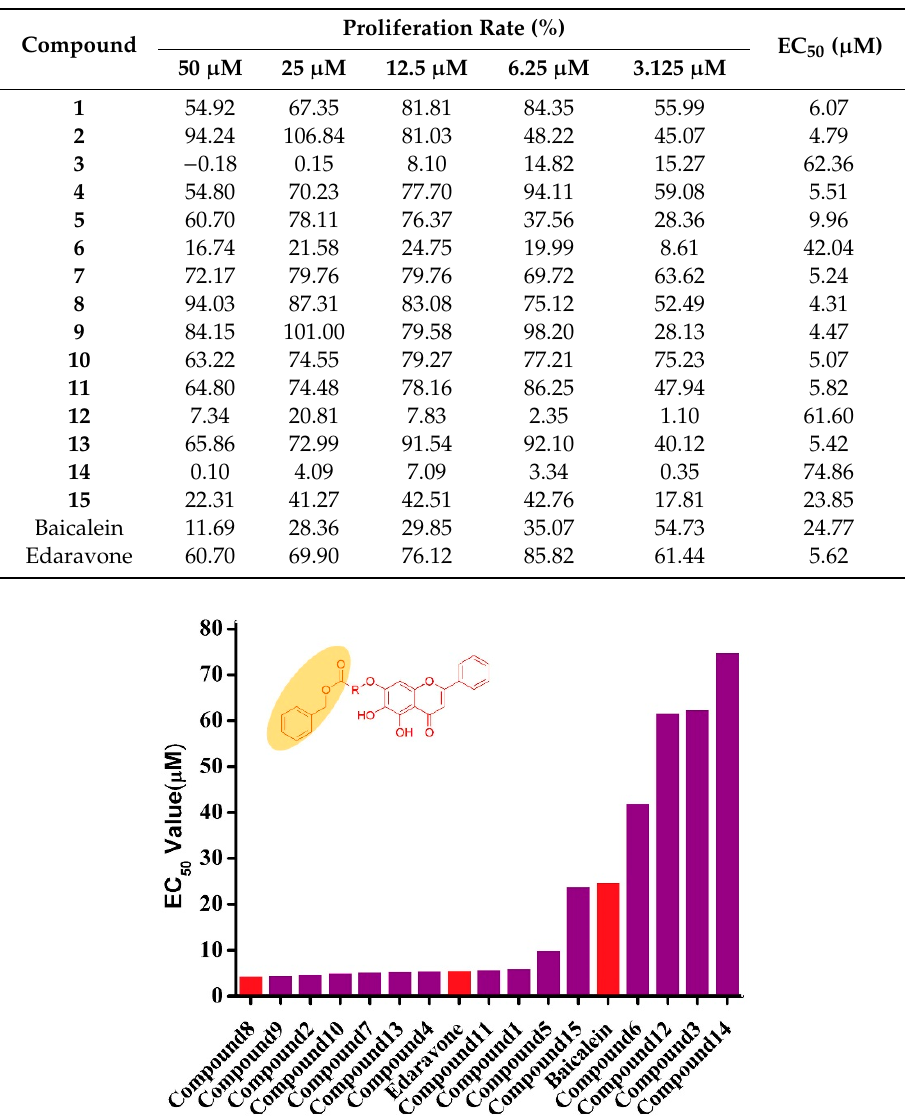
Table 2. The 50% effective concentration (EC 50 ) of baicalein derivatives for protecting injured SH-SY5Y cells.